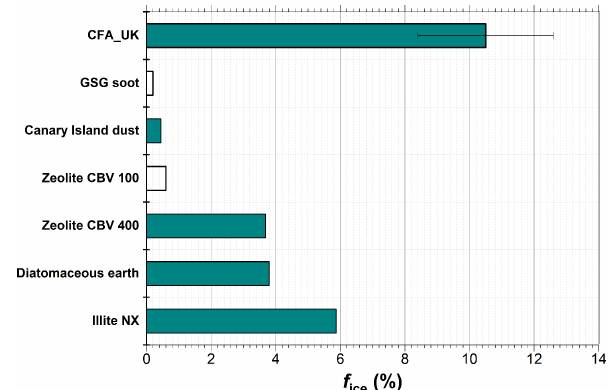
Figure 8. Comparison of the ice nucleation enhancement of CFA particles and other particles studied by Wagner et al. (2016). Ice- activated fraction (%) obtained at ∼ 250K start temperature is compared. The filled bars represent ice nucleation via depositional growth, whereas the unfilled bars represent ice nucleation via con- densational